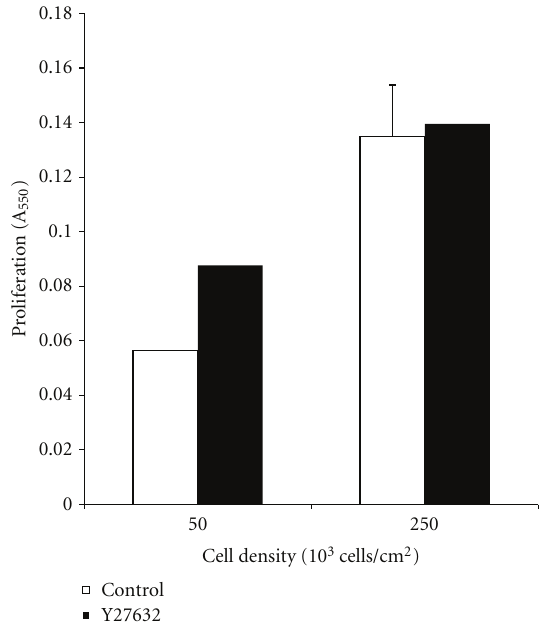
Figure 6: SW620 cells were seeded at densities 250 × 10 3 cells/cm 2 onto 1.5 and 4.0mg/mL collagen I gels. ROCK-1 was knocked down via siRNA to study the impact of ROCK-I on cell invasion in a low- and high-density environment. ROCK-I knockdown resulted in a 60% increase in invasion for cells seeded in both 1.5 and 4.0 mg/mL sca ff